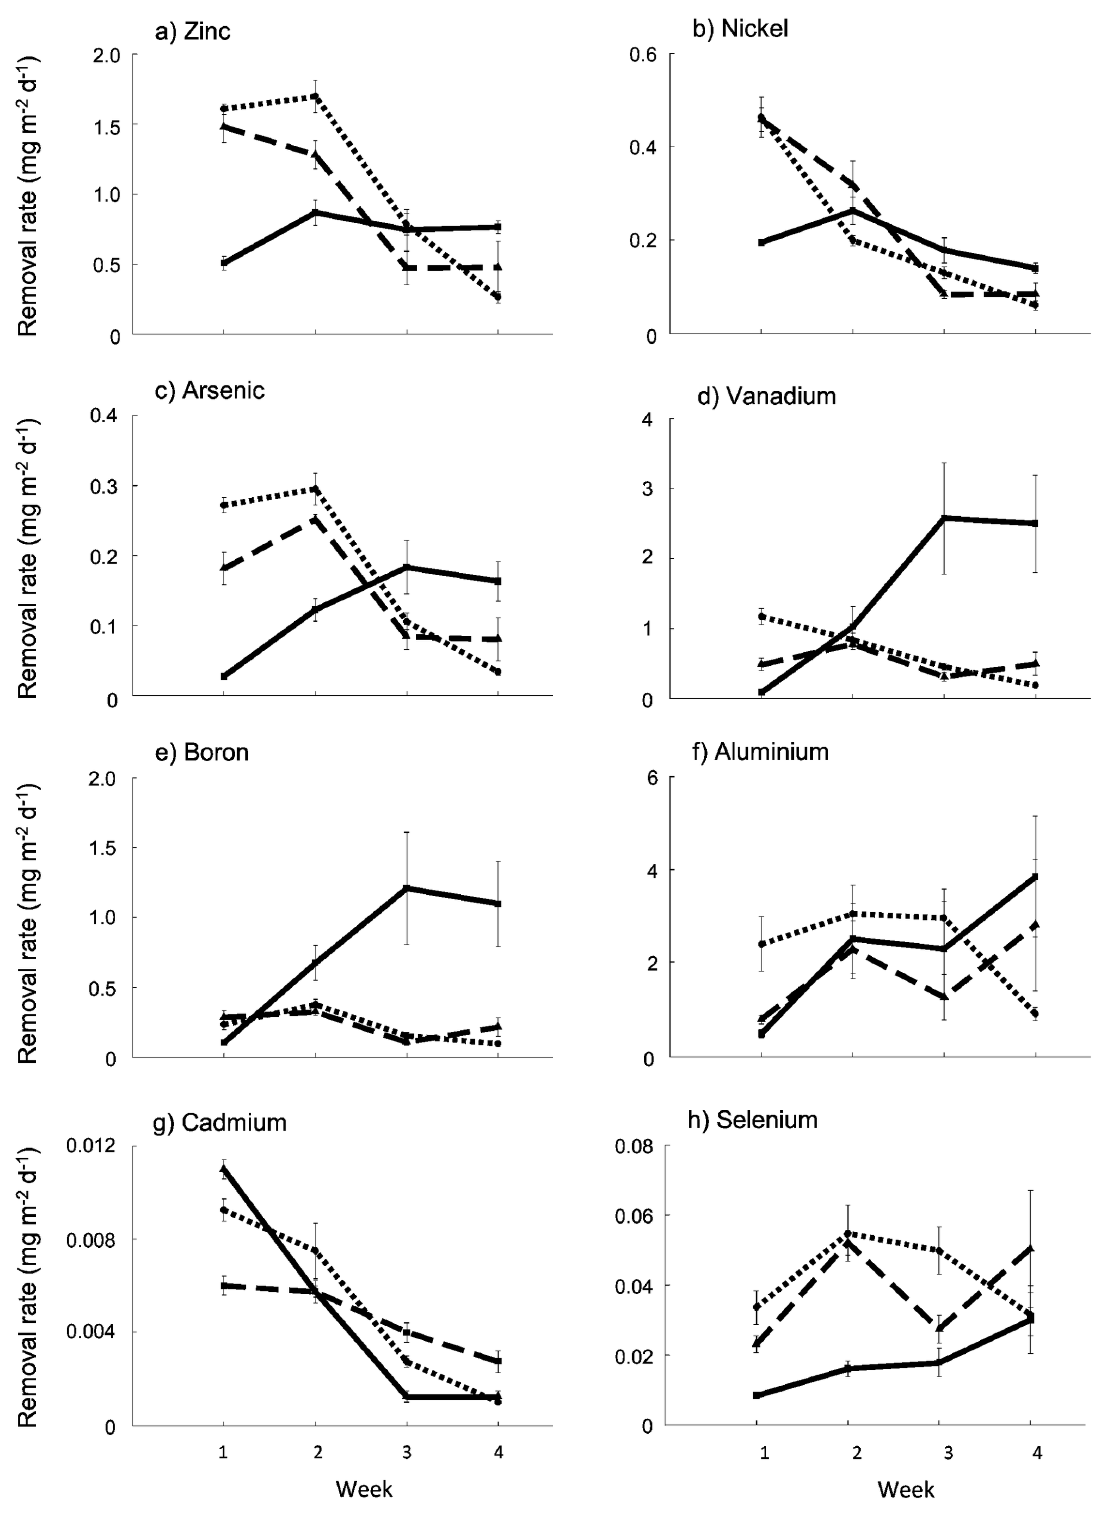
Figure 5. Areal sequestration (mg m -2 d -1 ) of metals and metalloids by Oedogonium sp. cultured in Ash Dam Water at three levels of carbon supplementation. Unbroken, dashed and dotted lines show data for the 0, 3 and 6 L min -1 CO respectively. doi: 10.1371/journal.pone.0081631.g005 PLOS ONE |